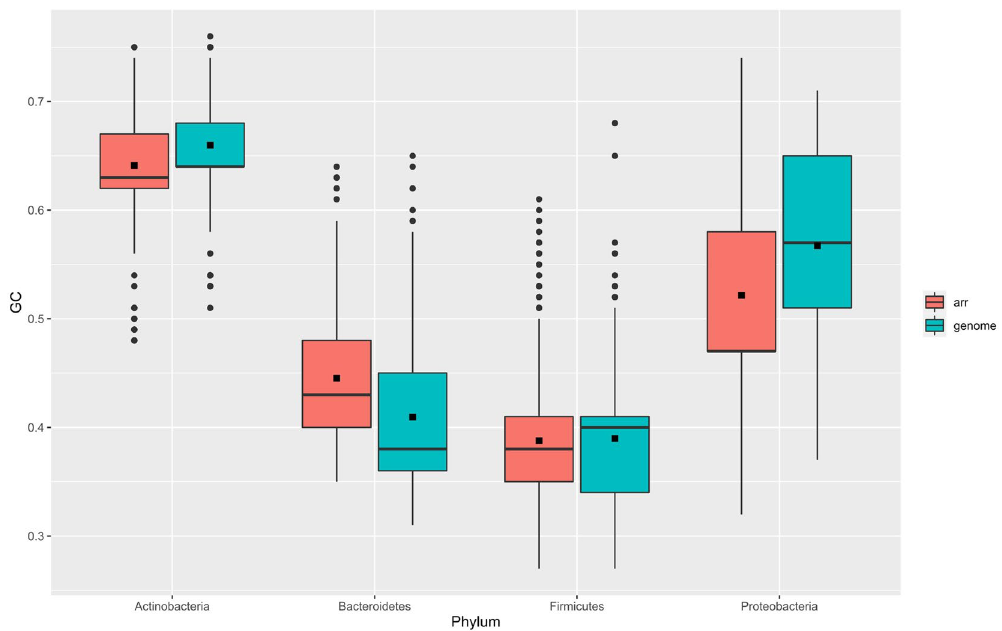
Figure 1. Comparison of GC content of arr genes and host genomes. Box plots are grouped based on the phyla with the greatest abundance of arr . The inner square of the boxplots corresponds to the mean value of the GC